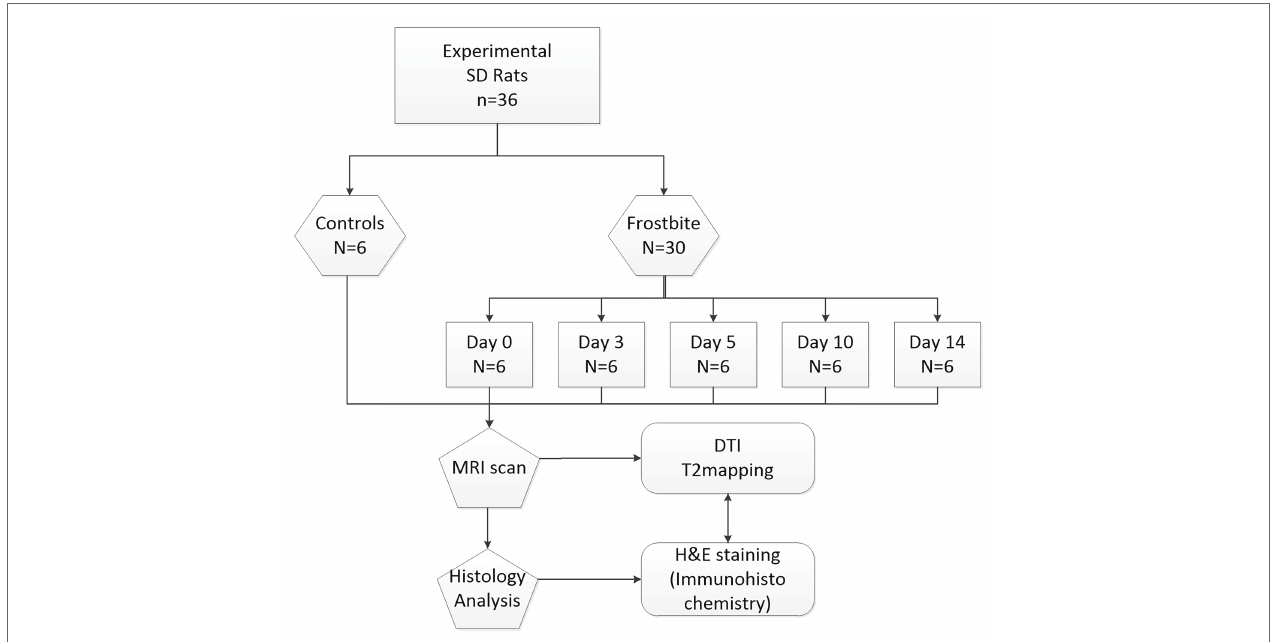
FIGURE 1 | Flowchart demonstrating the study design.